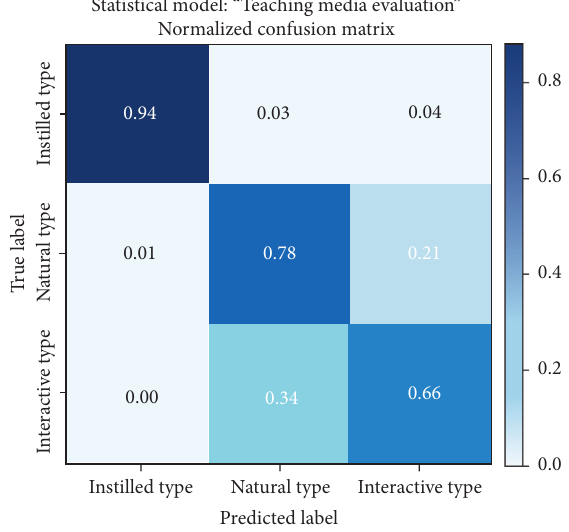
Figure 1: Statistical model: display of evaluation performance of “teaching type evaluation”